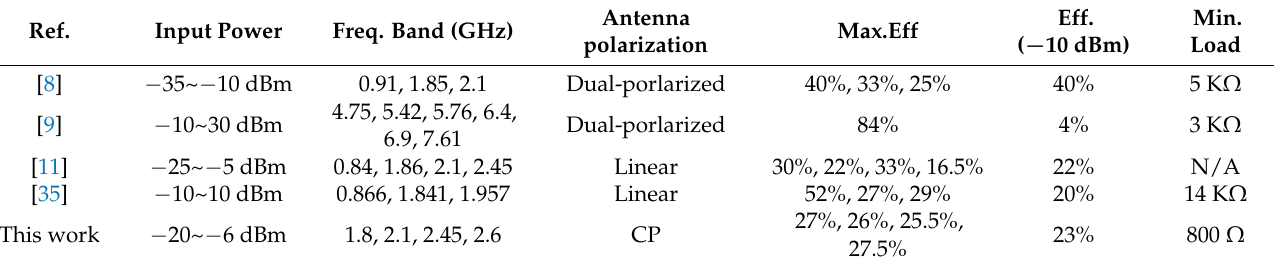
Table 3. Comparison with previous